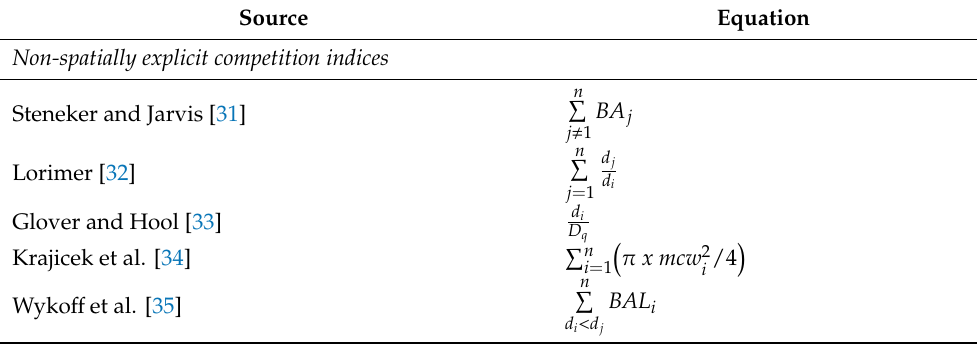
Table 2. Sources of competition indices and corresponding formulas, tested for use in the individual tree basal area growth model. i , subject tree; j , neighbor tree; d i , DBH of subject tree (cm); d j , DBH of neighboring tree (cm); BA j , basal area of neighboring trees (cm 2 ); BAL i , basal area of trees larger than the subject tree (cm 2 plot − 1 ); D q , quadratic mean diameter (cm); h i , height of subject tree (m); h j , height of neighboring tree (m); L ij , distance between subject tree and neighboring tree j ; n , number of neighboring trees; mcw i , maximum crown width (m); a ij , area of influence zone overlap